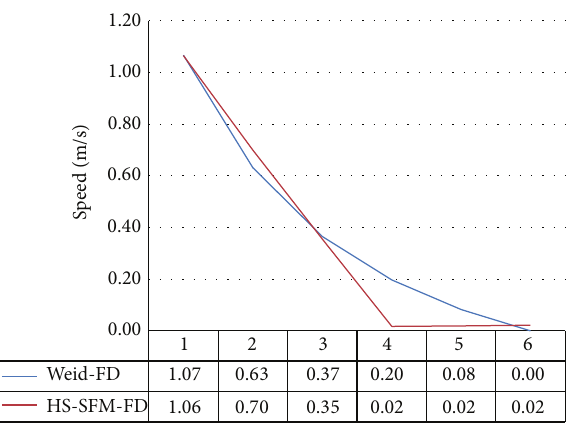
Figure 2: The fundamental diagrams of our HS-SFM simulations compared with Weidmann